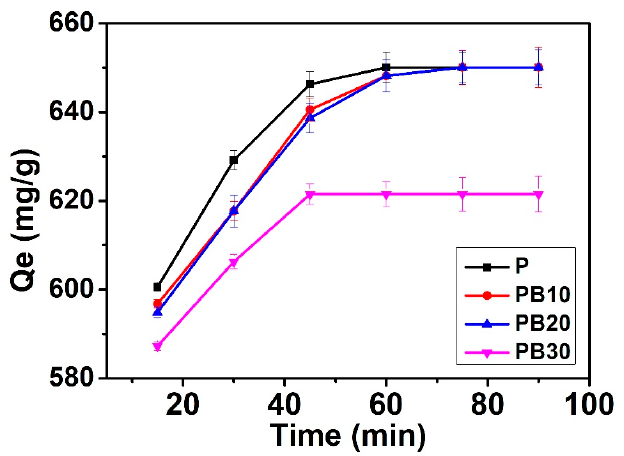
Figure 12. Adsorption capacity towards Ni 2+ of polymer-modified gauze (P), and polymer/BiOBr- modified gauze samples (PB10, PB20, PB30).